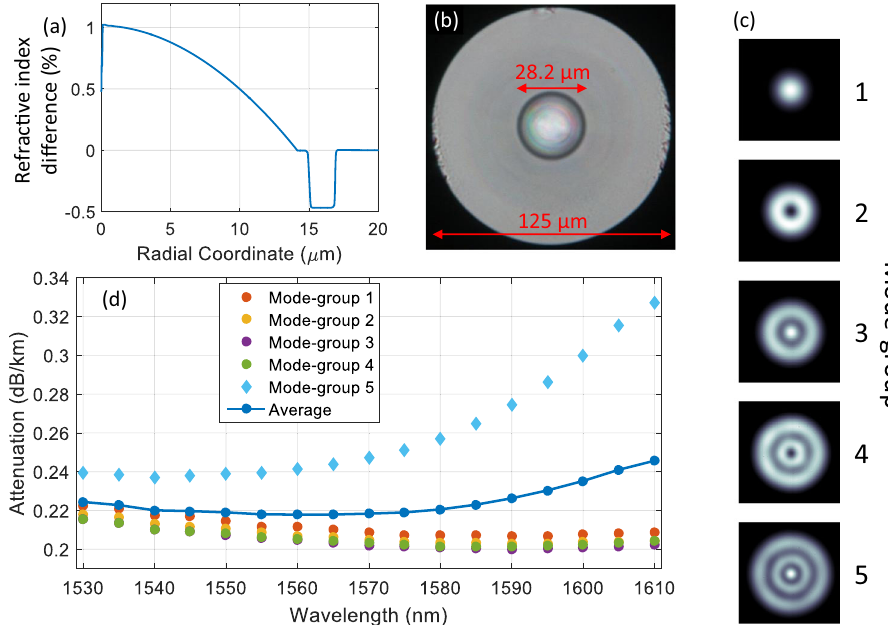
Fig. 3 15-mode transmission fi ber. a Refractive index pro fi le of the trench-assisted, graded-index 15-mode fi ber. b Photograph of the fi ber ’ s cross-section. c Camera recording of the output mode intensity pro fi les after 7.6 km 15-mode fi ber when excited with ASE noise of 40 nm bandwidth. Only one mode is shown per mode group, as all modes within one mode group have equal intensity patterns. Different numbers of radial intensity maxima con fi rm a strong mode group selectivity of mode-multiplexer and fi ber. d Wavelength-dependent attenuation measurements of the 23 km long 15-mode fi ber. The fi fth mode group has a higher attenuation, attributed to increased micro-bending